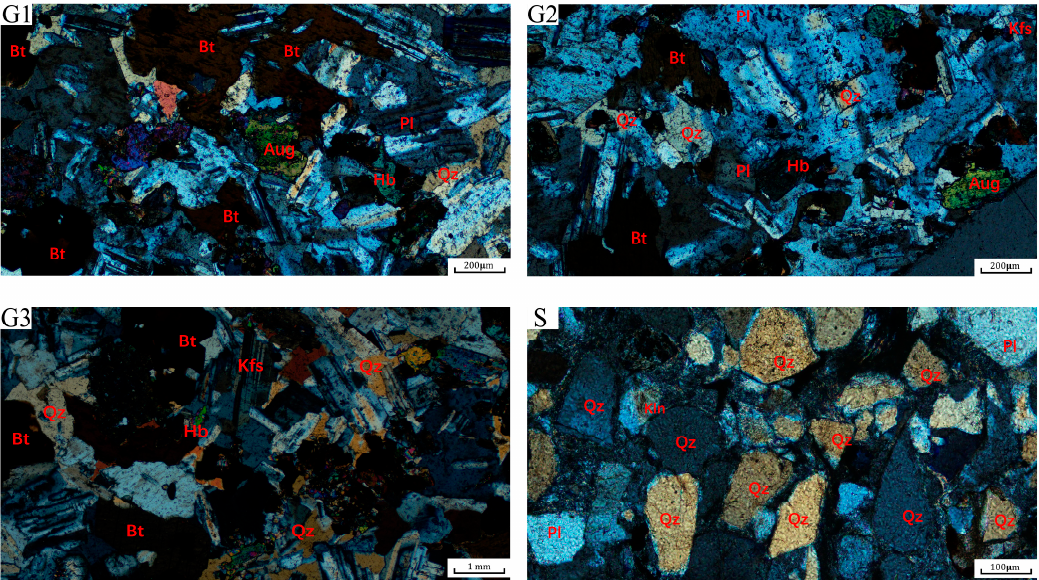
Figure 3. Micrographs of G1, G2, G3, and S lithological specimens by a single-polarization microscope.